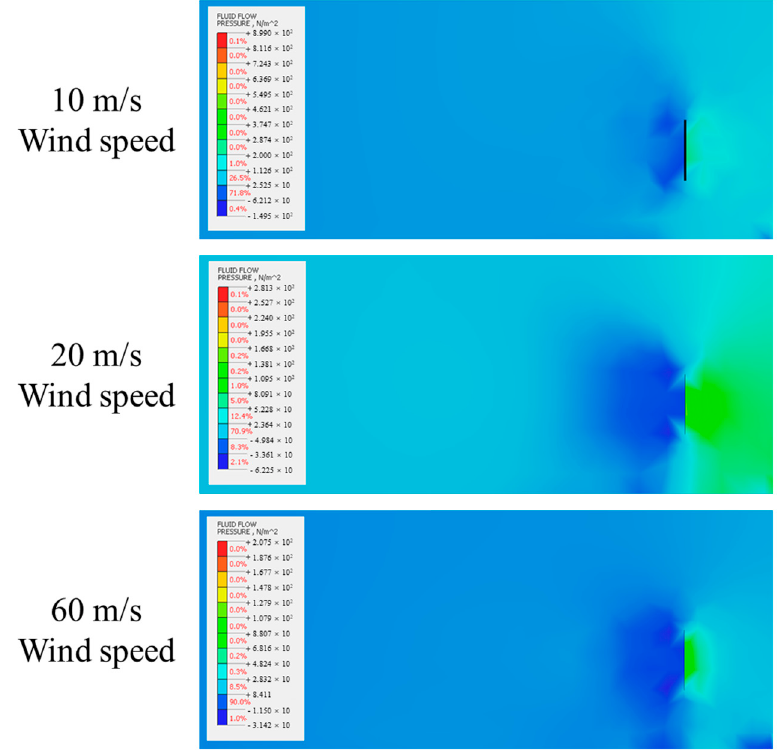
Figure 11. Wind speed distribution of perforated road sign by wind speed.